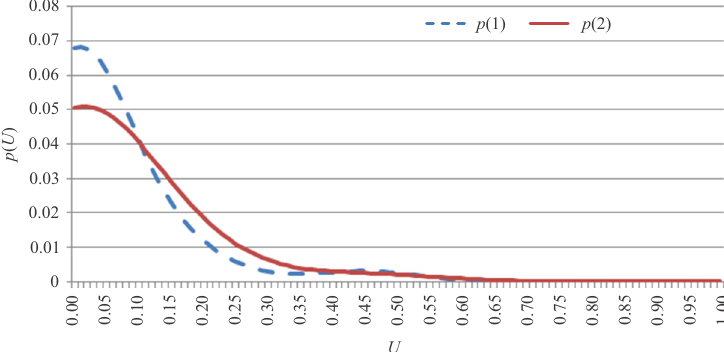
Fig. 2. Probability densities for yield loss rates for potatoes in Vilnius